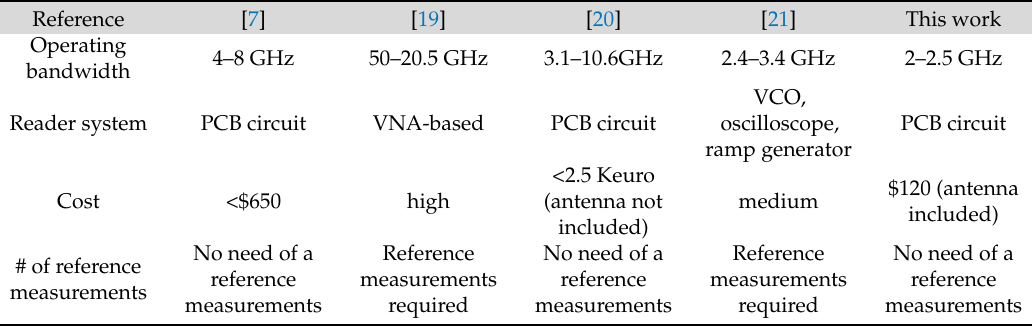
Table 2. Performance and cost comparison of chipless RFID tag readers.